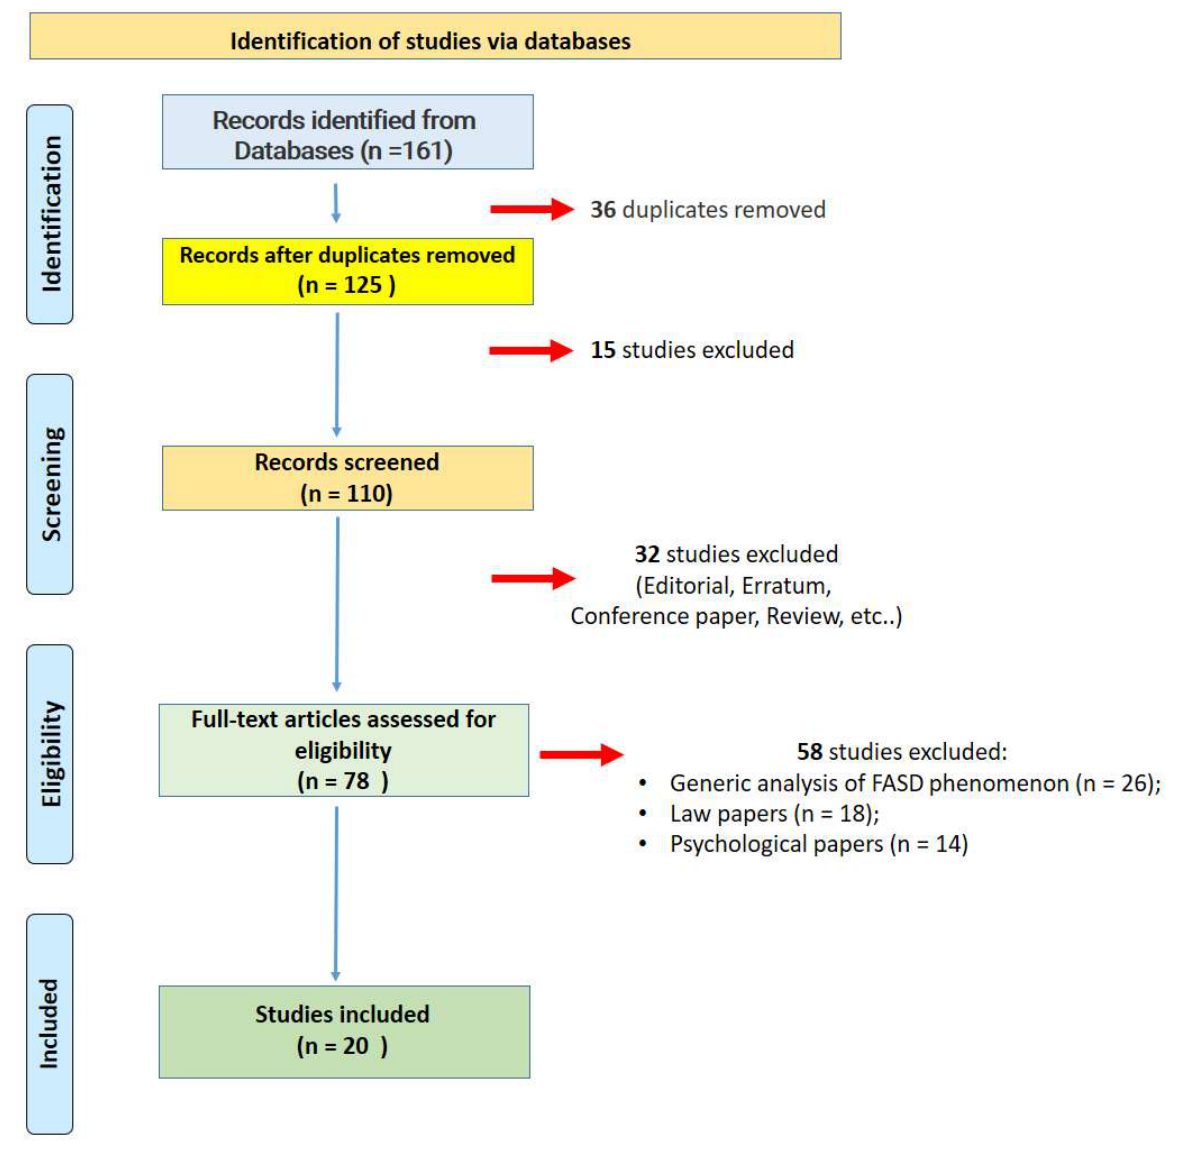
Figure 1. Flow diagram illustrating included and excluded studies in this systematic review.